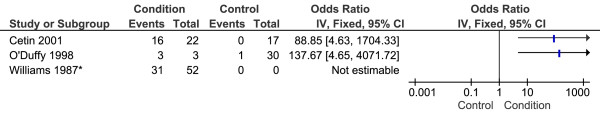
Forest plot of studies reporting increased subcalcaneal radioisotope uptake. *Control group sample size not reported.